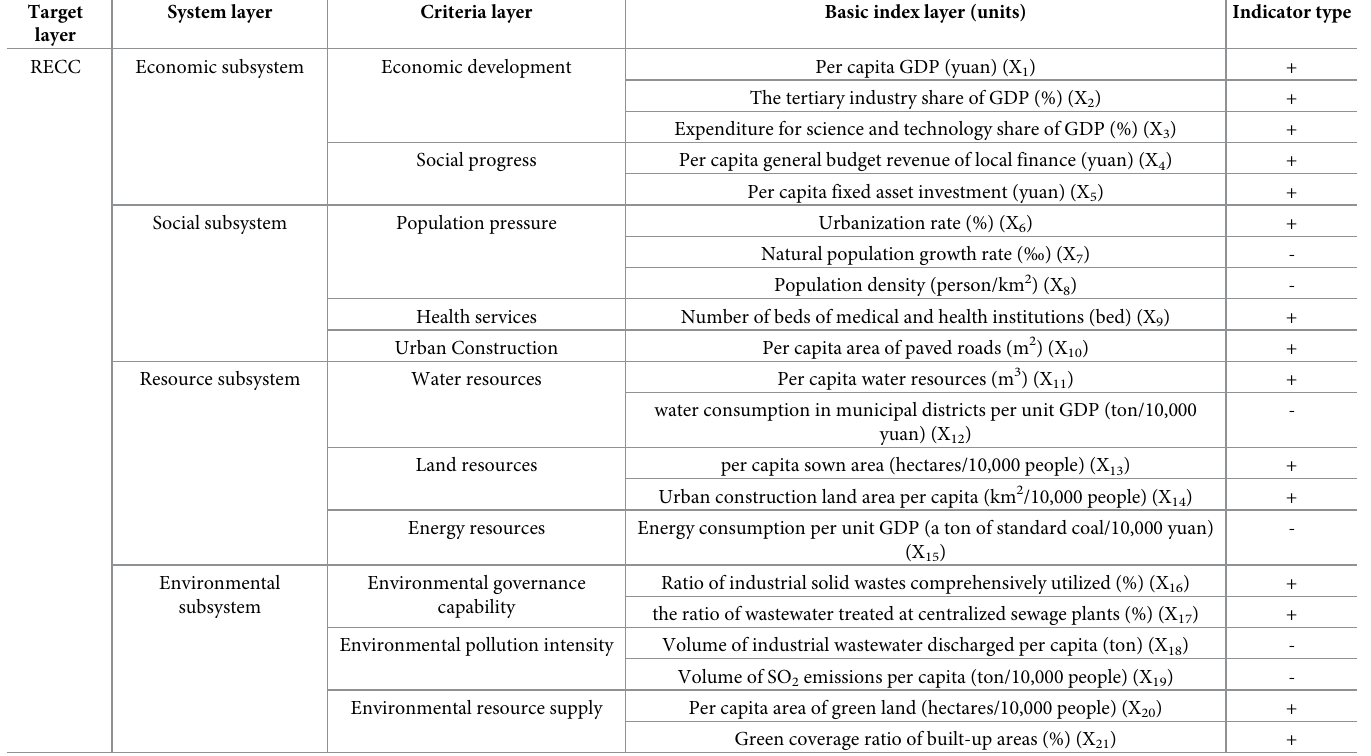
Table 2. Indicator systems of resource and environmental carrying